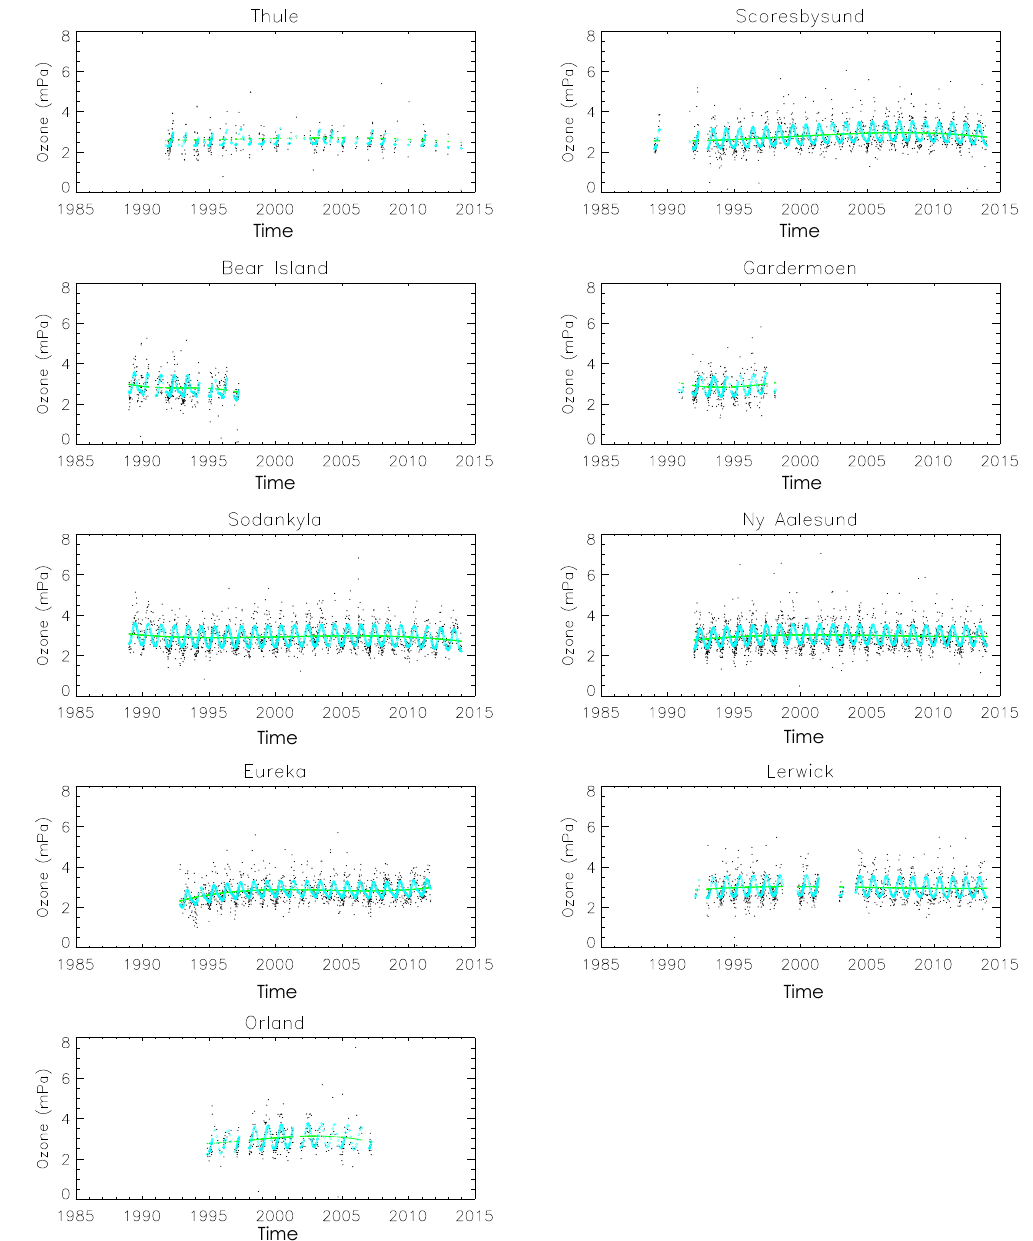
Figure 4. Ozone at 500hPa (partial pressure mPa) for the nine stations. Observations (black), model mean fit (cyan), and polynomial part of the model (green) as a function of time at 500hPa. Model settings: n pol = 4, n cyc = 2, n a tr = n θ tr = 0, and white